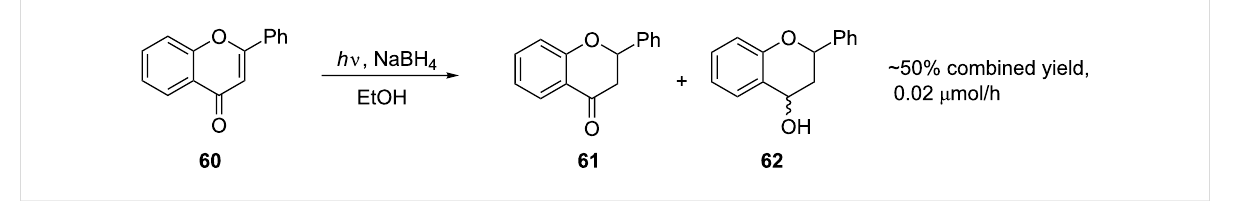
Scheme 19: Light-promoted reduction of